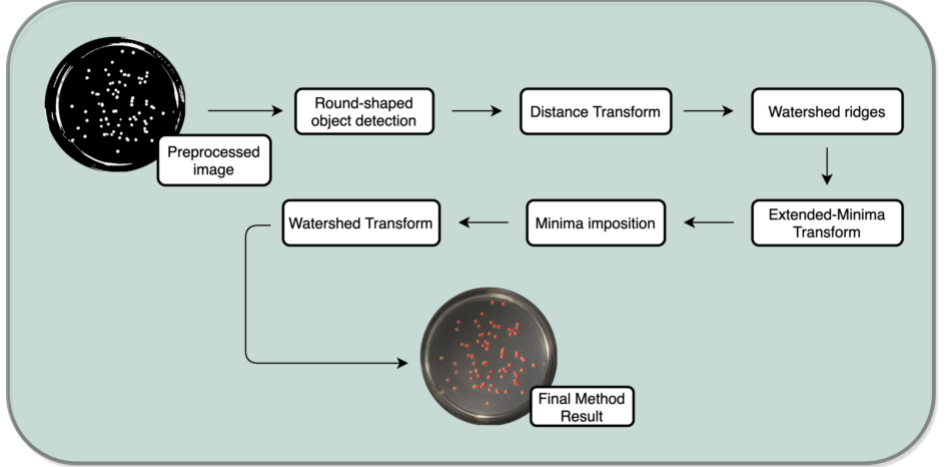
Figure 11. Processing task.